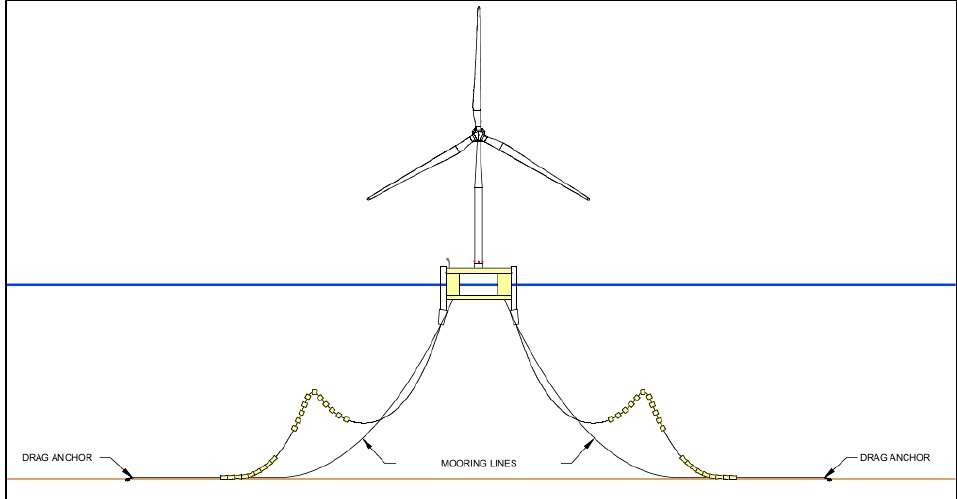
Figure 5. Schematic of the subsea mooring and cabling system of a floating turbine. Source: